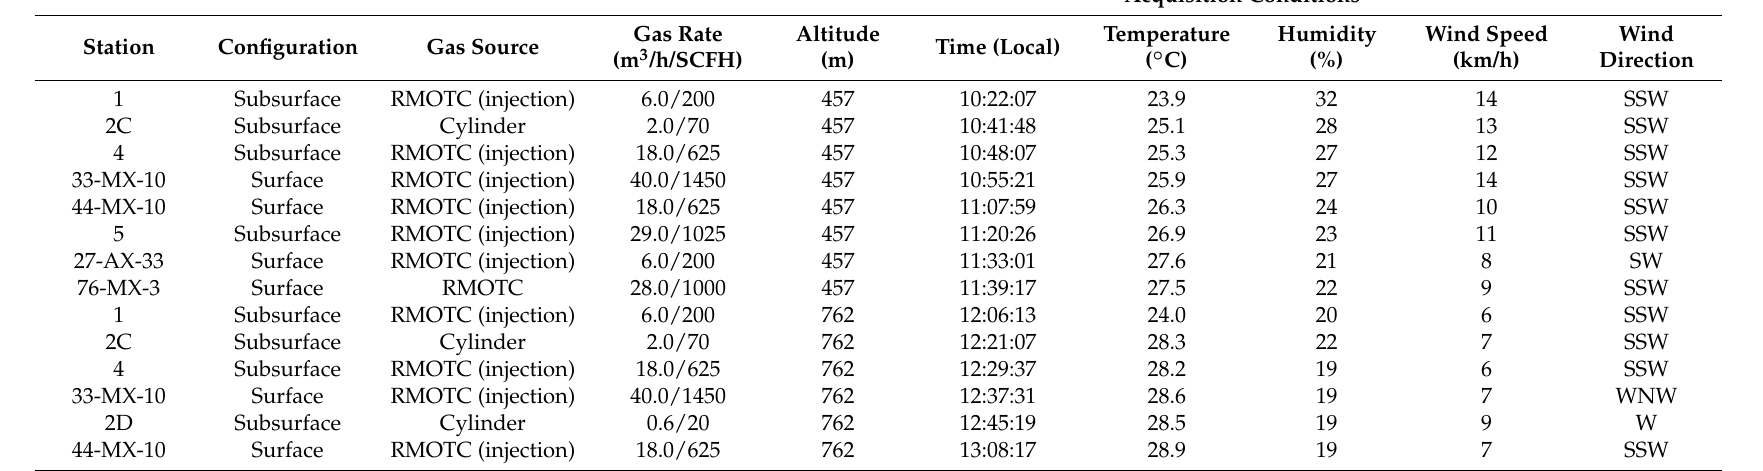
Table 1. Specifications of CH 4 leak stations and data acquisition parameters, including: emission rates from each station (m 3 /h and SCFH), acquisition altitude (m), acquisition time and meteorological data acquired at RMOTC with a weather station during the experiment. Weather data was collected on 20 August 2010 every five minutes, from 8:00 a.m. to 2:00 p.m. Temperature, humidity, and wind speed and direction presented in this table corresponds to data collected concomitantly with the time of the airborne survey over each gas leakage